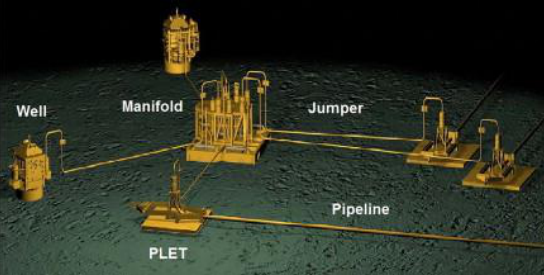
Figure 1. A pictorial representation of subsea structures whose relative positions are measured through subsea metrology techniques (Bai and Bai,